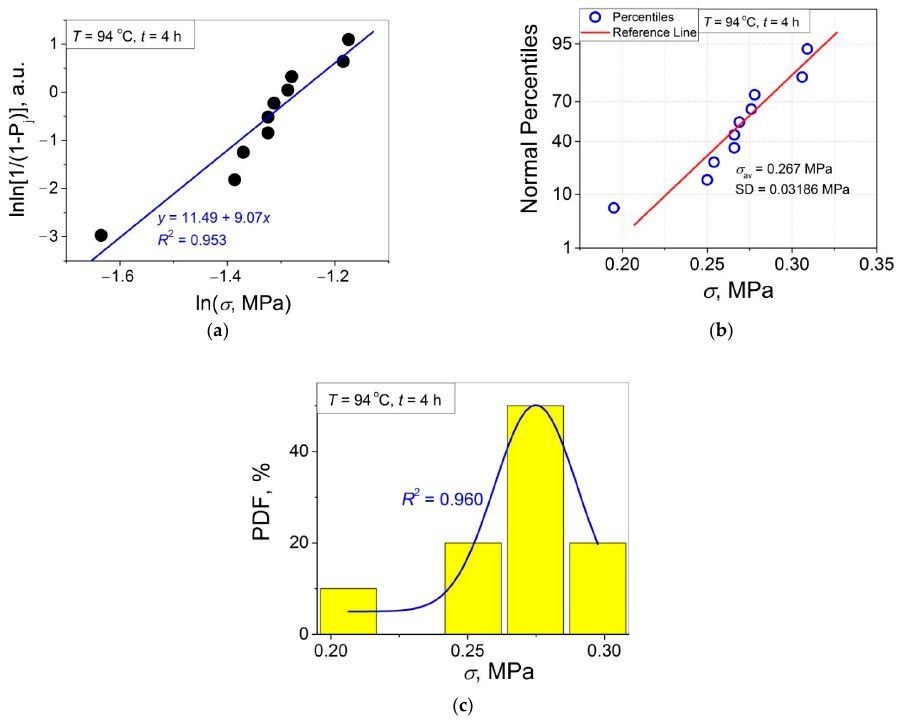
Figure 5. ( a ) Linear regression fit of the lap shear strength σ in Weibull’s coordinates; ( b ) normal probability plot; ( c ) probability density function (PDF) vs. σ fitted with a Gaussian function for an amorphous PET–PET interface self-bonded at T = 94 °C for t = 4 h.